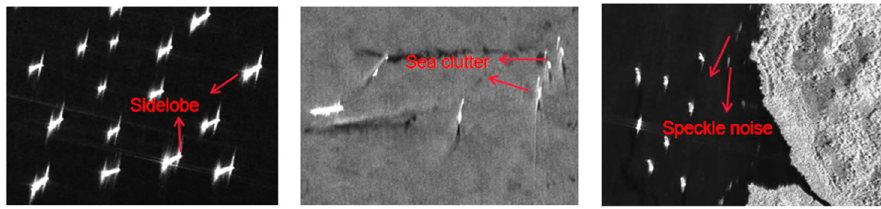
Figure 9. Graphical representation of different interference factors in images.